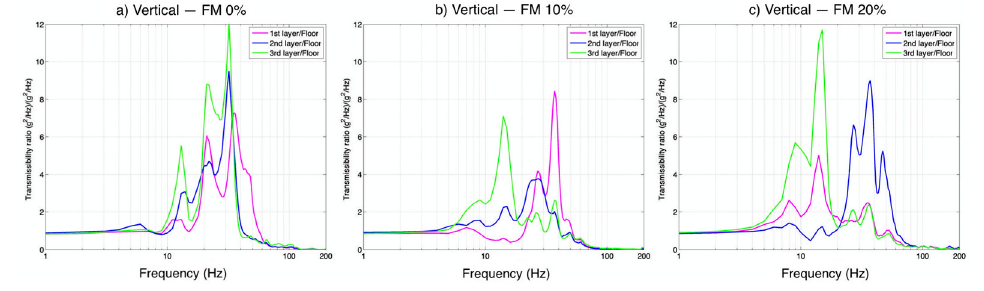
Figure 7. Transmissibility plots of the various layers in the vertical direction for ( a ) FM 0%, ( b ) FM 10%, and ( c ) FM 20%.